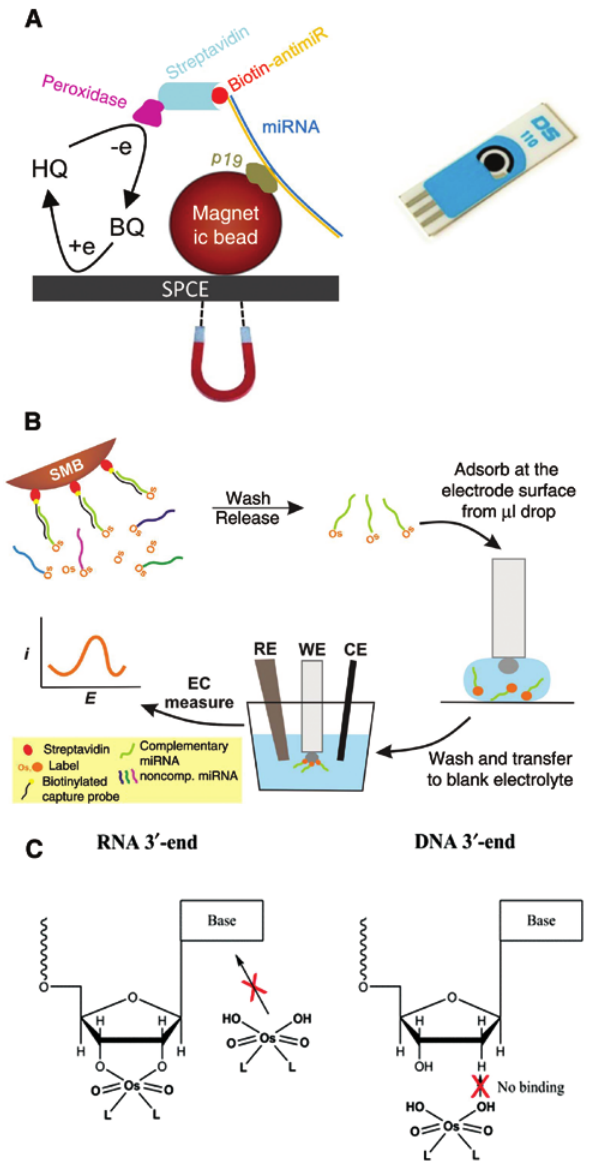
Figure 5: Examples of EC-based assays for miRNA detection. (A) Strategy based on p19 protein, which selectively captures RNA/ RNA hybrids, in this case, a miRNA of interest hybridized with a properly designed RNA probe labeled with biotin. Subsequent addition of streptavidin/peroxidase generate EC signal, measured at screen-printed carbon electrodes (shown right). (B) Osmium- based approach. Biotinylated capture probes (black) immobilized at the streptavidin magnetic beads (SMB) hybridize with six-valent osmium-labeled miRNA complementary to the probe (green), fol- lowed by stringent washing to remove interfering molecules and by a release of the captured miRNA into solution. Labeled miRNA is then adsorbed at the electrode surface and transferred into the blank electrolyte for EC measurement. Reprinted from Bartosik et al. (2014a) with permission from Wiley. (C) Reaction of Os(VI)L with ribose at the 3 ′ -end of the RNA molecule. The Os(VI)L complexes do not react with nucleic acid bases or deoxyribose. L is nitrogenous ligand e.g. 2,2 ′ -bipyridine, temed,